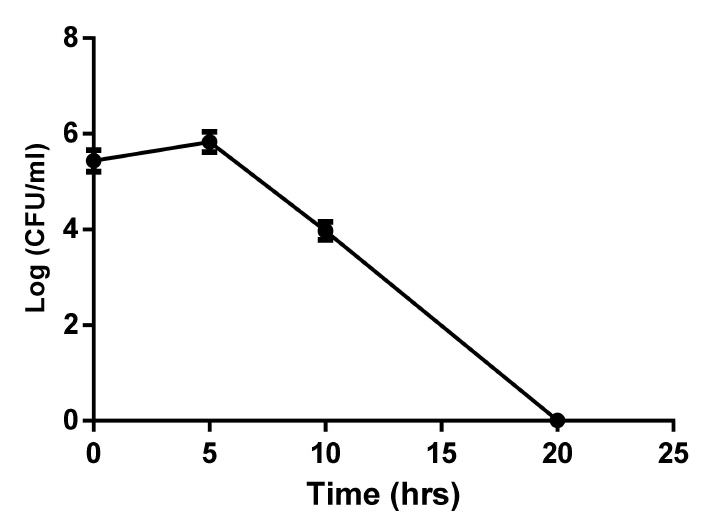
Figure 4. Growth curve of S. aureus against PHELA ®